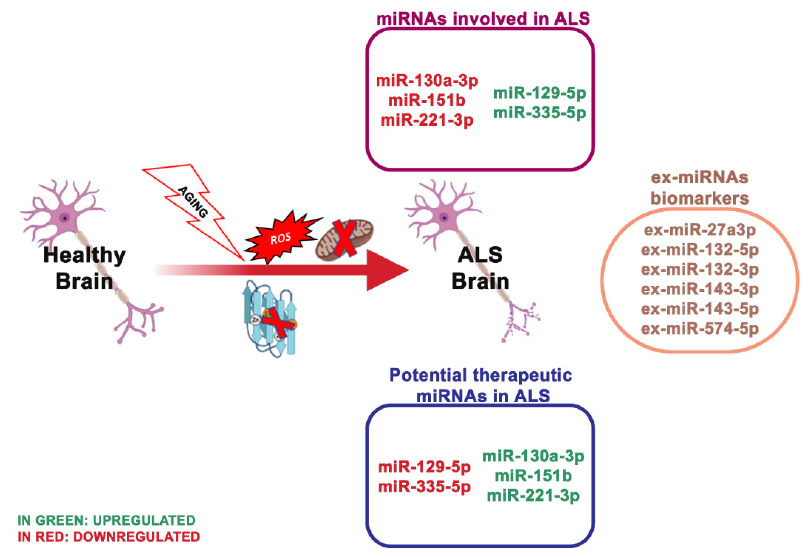
Figure 4. The most essential miRNAs involved in ALS’s disease.